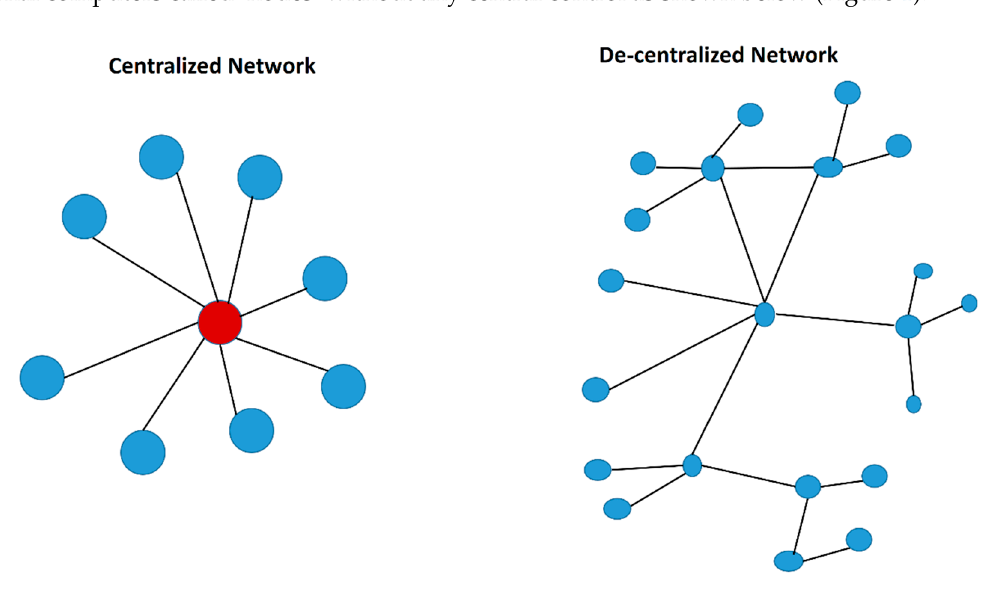
Figure 1. Centralized versus decentralized network.